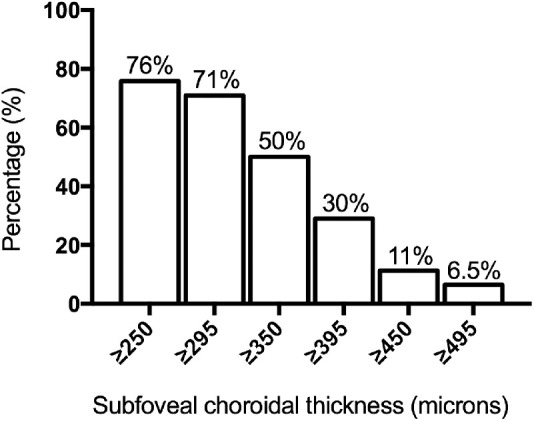
Graphical representation of subfoveal choroidal thickness distribution according to different thickness thresholds. The x-axis is the distribution of eyes according to subfoveal CT thresholds; the y-axis is the percentage of eyes. More than 50% of eyes had a subfoveal CT greater than 350 µm. Subfoveal CT measurements (central 1 mm) were performed using a Triton swept-source OCT.